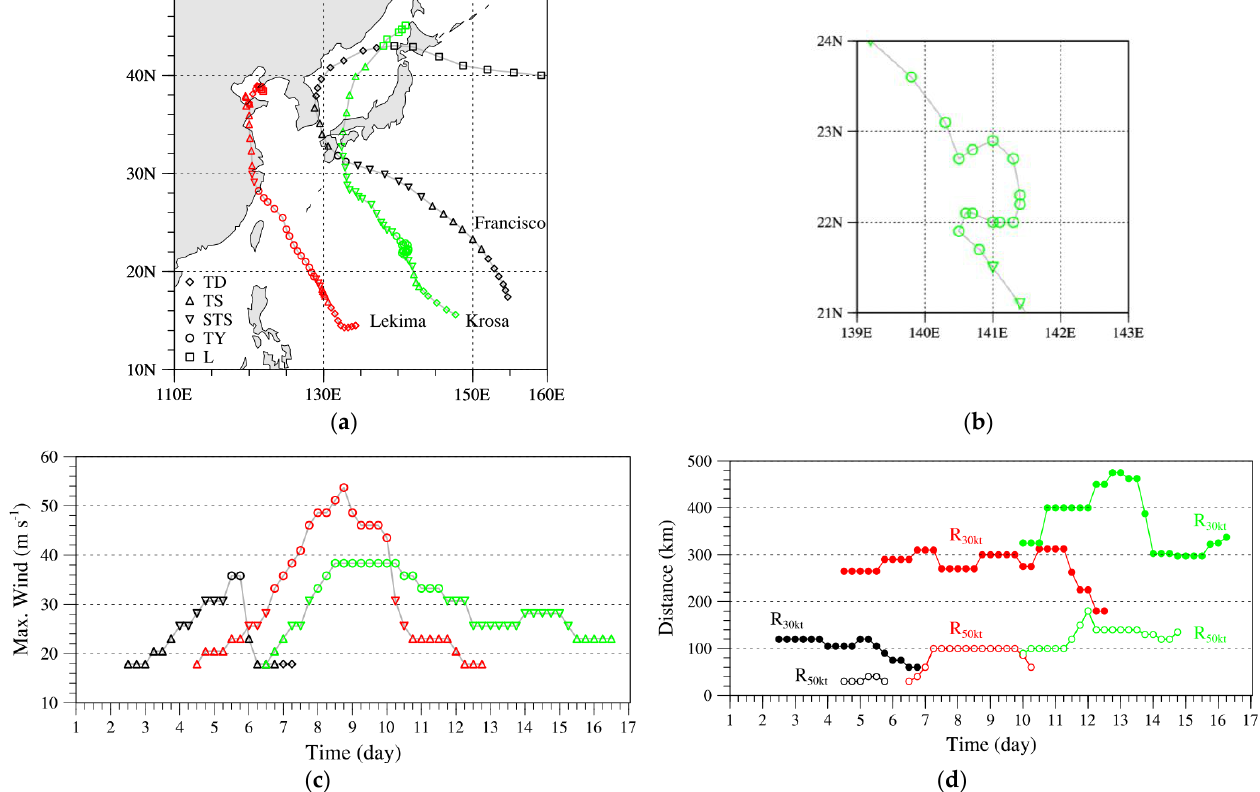
Figure 2. ( a ) The RSMC-Tokyo best tracks along with ( b ) zoomed areas, ( c ) the maximum sustained wind, and ( d ) the radii of 30-kt (solid circles) and 50-kt (open circles) wind for typhoons Francisco (black), Lekima (red and magenta), and Krosa (green and blue) in August 2019.